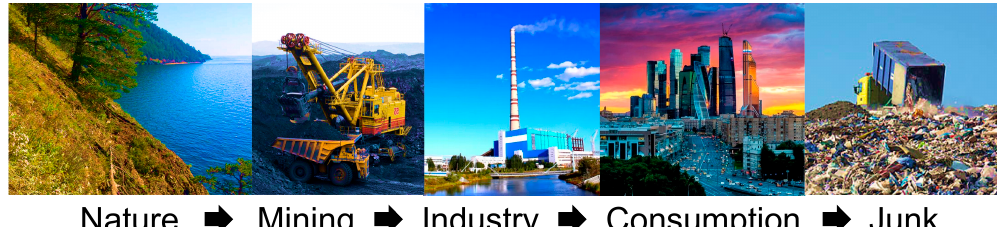
Figure 6. How mankind moves materials. Natural resources are shrinking; demand and consumption are increasing; landfills are growing; water and atmosphere are polluted. Images: Baikal lake; coal mining in Kuznetsk basin (Kuzbass); Ekibastuz GRES-2 power plant with 420-m chimney; Moscow city; a landfill. Images are from the open sources.